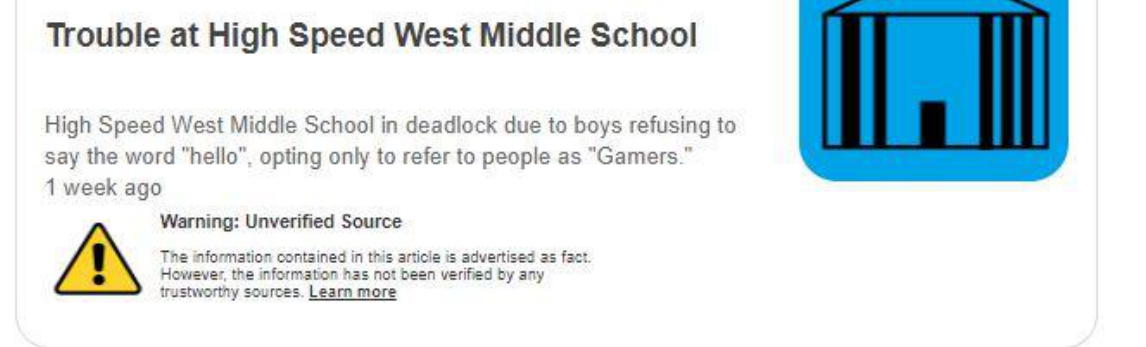
Figure 68. Warning label 2 [16].